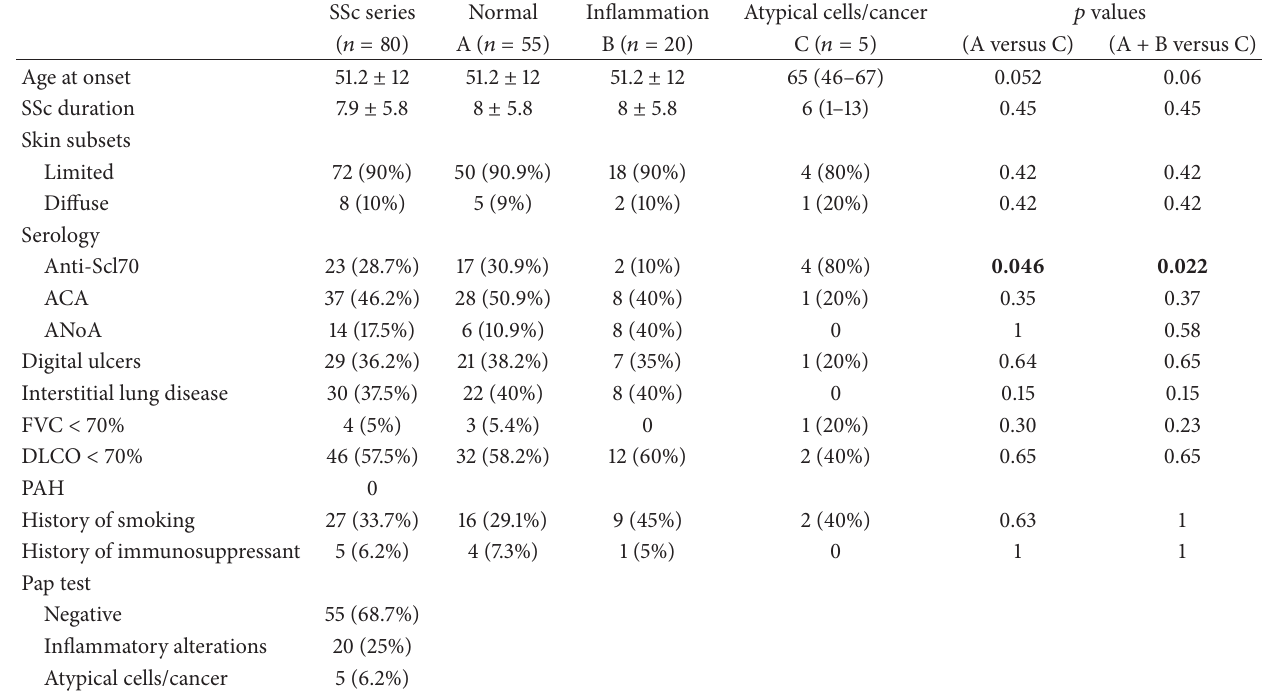
Table 1: Clinical features and pap test screening findings in 80 SSc